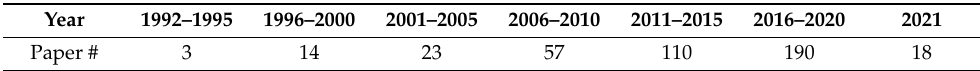
Table 1. All publications found with the search